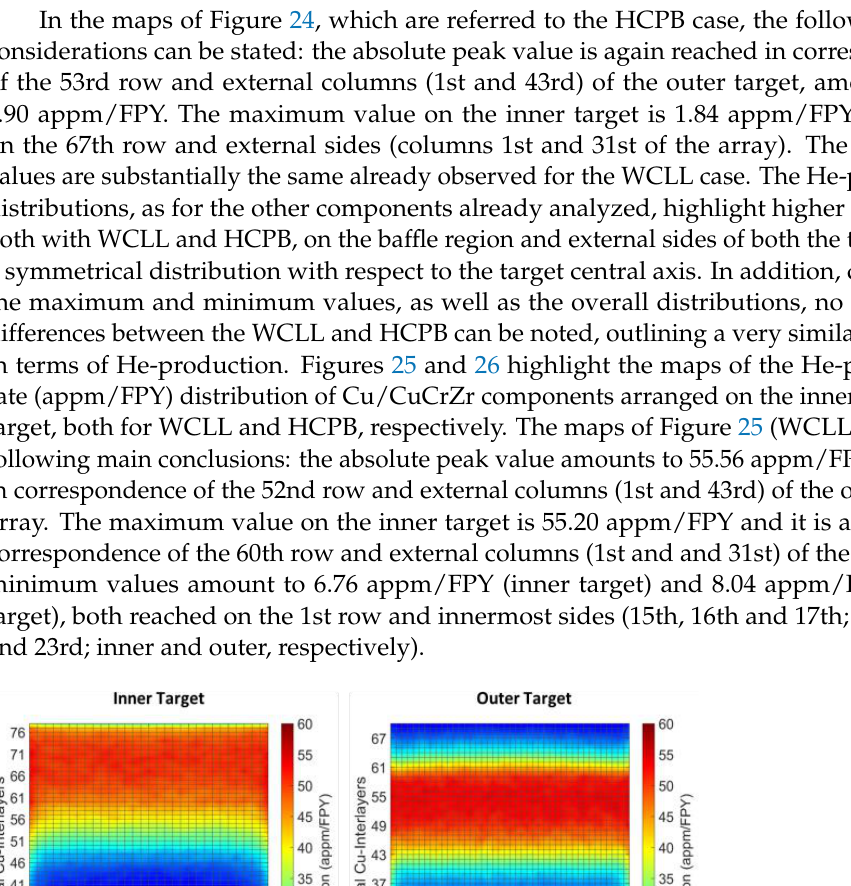
Figure 24. He-production (appm/FPY) distribution on W-monoblocks of the inner ( left ) and outer ( right ) target, with HCPB blanket.